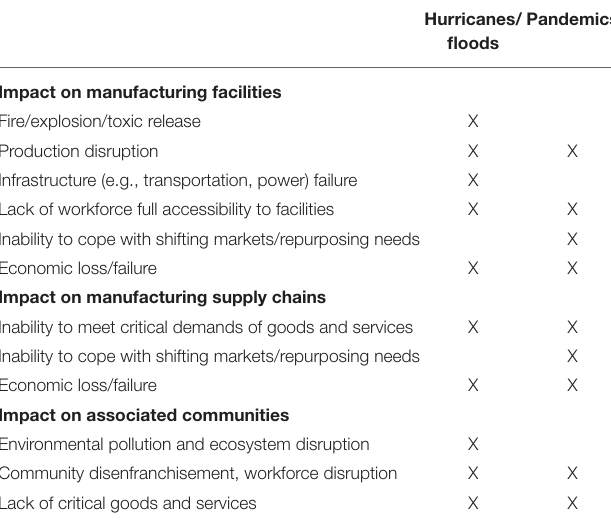
TABLE 1 | Main impacts of hurricanes, floods, and pandemics on the manufacturing sector and communities.